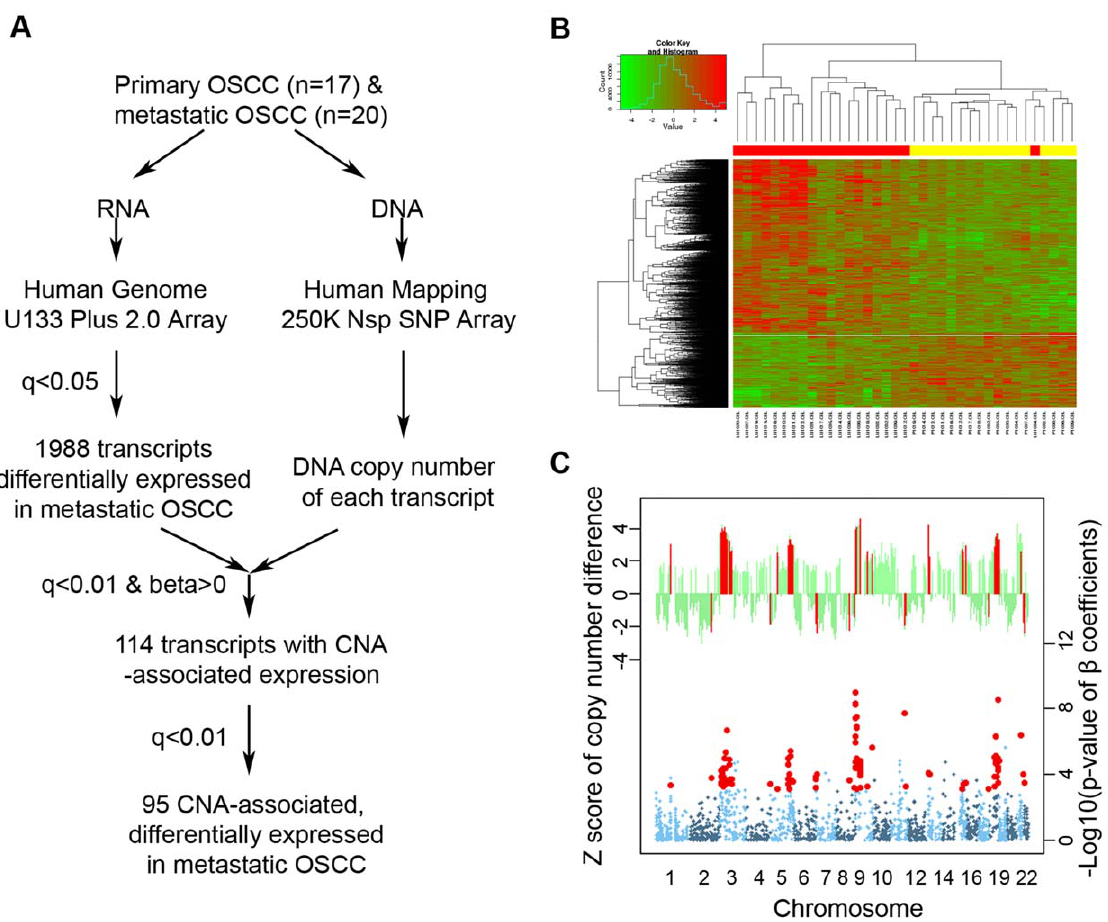
Figure 1. Identification of DNA copy number–associated differentially expressed genes in metastatic OSCC. A) Integrative genomic analysis workflow; B) Heat-map of the 1,988 transcripts with differential expression between non-metastatic primary and nodal metastatic OSCC. Specimen code: Red=metastatic OSCC; Yellow: primary OSCC; C) Top panel: the z-score of the DNA copy number difference between primary and metastatic OSCC. Each bar represents one of the differentially expressed genes. Genes with significant Z-score differences are highlighted in red. Bottom panel: Manhattan plot showing the -Log10 transformed p-value of the correlation coefficients of CNA and gene expression. Each dot represents one of the differentially expressed genes. Genes with different copy number in primary and metastatic OSCC are highlighted in red. The 4 regions with cluster of CNA-associated differentially expressed genes are indicated. ratios (HR) for patients in cluster 2 were 3.45 (95% CI: 1.84–6.50)